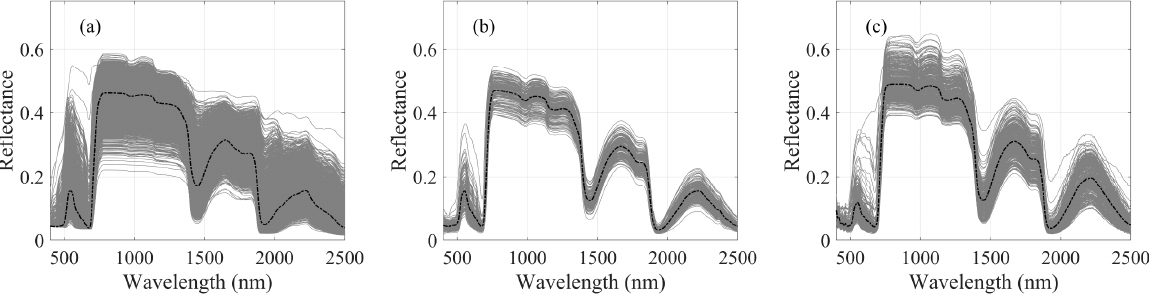
Figure 2. Leaf spectra (raw values in 1 nm resolution) in different datasets (( a ): simulation dataset, ( b ): dataset A, ( c ): dataset B). Each gray line represents the reflectance of one leaf sample. The dashed line in each panel represents the averaged value at each wavelength for all leaf samples.